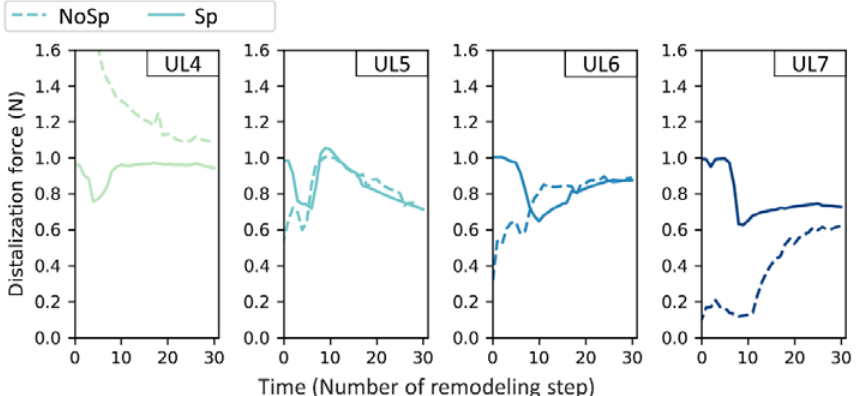
Figure 6. Changes in the distalization force transmitted to each tooth over time. Forces were more evenly distributed in the Sp model.